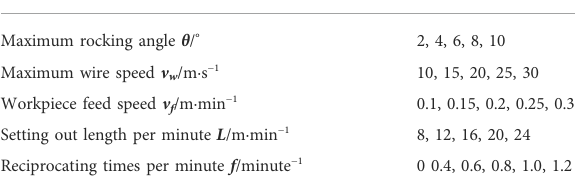
FIGURE 8 Numerical simulation fl owchart of the wire saw wear